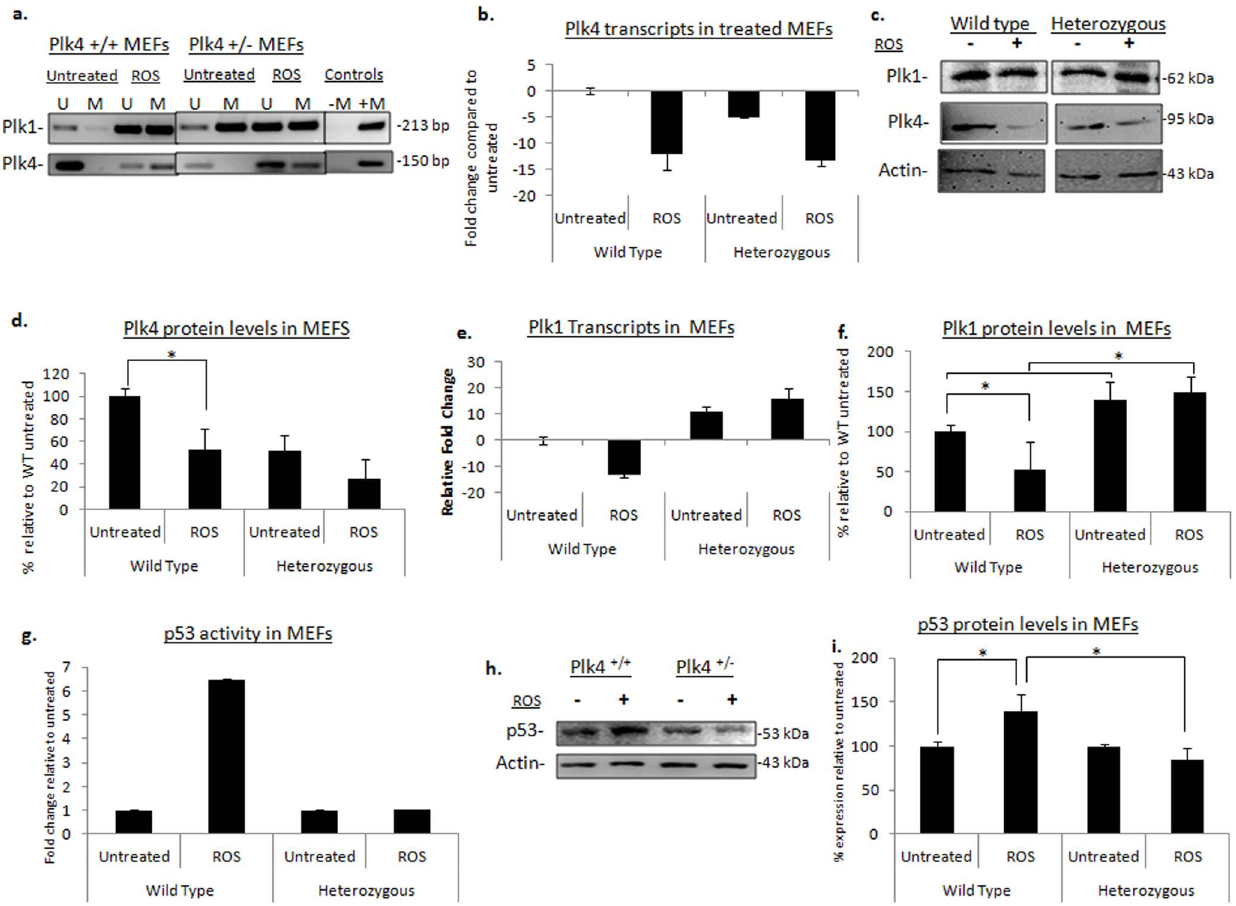
Figure 2. Modification of plk1 and plk4 epigenetic marks with ROS exposure in MEFs. (a) MSP analysis shows the promoter methylation of plk1 and plk4 pre- and post-ROS treatment; U=unmethylated, M=methylated. Fully methylated NIH 3T3 DNA was used as a positive control ( + M), no template was added to the negative control ( 2 M). (b) Plk4 transcript levels determined by qPCR. All transcripts were normalized to the wild type untreated control. All qPCR data is representative of the mean value of three independent experiments and error bars represent + / 2 SD. (c) Plk1 and plk4 protein levels examined via Western blot analysis, actin was used as a loading control. ( 2 ) represents the lysates from untreated cells, ( + ) lysates from cells grown in the presence of ROS (d) Plk4 protein expression levels determined by densitometry. All densitometry data is representative of three independent experiments and the error bars represent + / 2 SD. * denotes significance with a p , 0.05. (e) Plk1 transcripts of cells treated with ROS, the transcripts were normalized to the respective untreated samples. (f) The relative plk1 protein levels post treatment was normalized to the wild-type untreated samples. Levels determined by densitometric analysis of Western blot images. (g) An ELISA-based p53 activity assay. Relative activity was determined by normalizing values to the untreated samples. This data represents the mean value obtained over three independent experiments and error bars denote the + / 2 SD. (h) p53 protein levels in MEFs post treatment as determined by Western blot analysis. (i) Densitometry was performed on three independent experiments and all data has been normalized to the respective untreated. The mean expression is presented with error bars denoting + / 2 SD. * denotes significance with a p , 0.05.